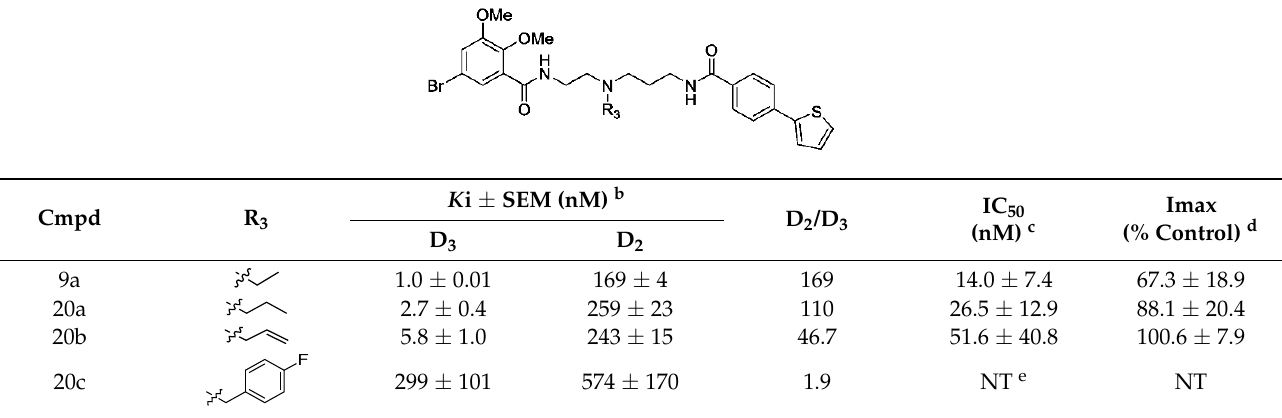
Table 2. Binding affinities of different sized substituents on the tert -amine a .